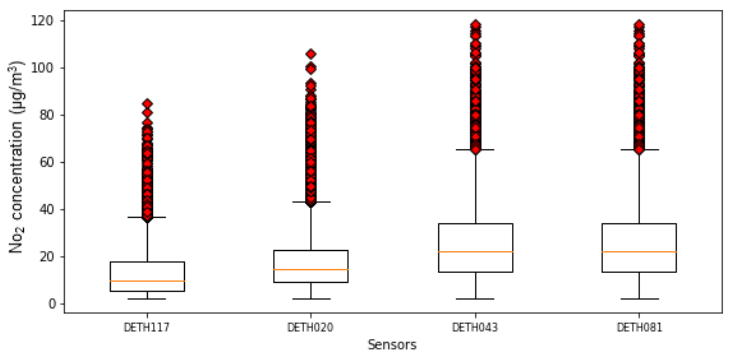
Figure 3. Box plots for the four sensors.